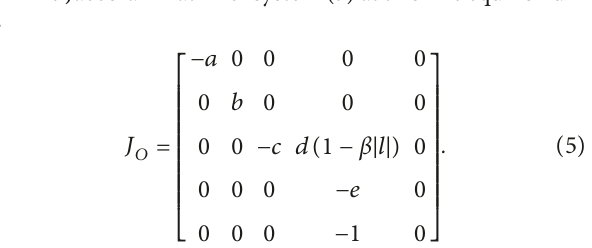
Figure 1: A typical four-wing hyperchaotic attractor of the 5D FWMHS (1) and perpetual points (red) in the (a) x plane, (c) x